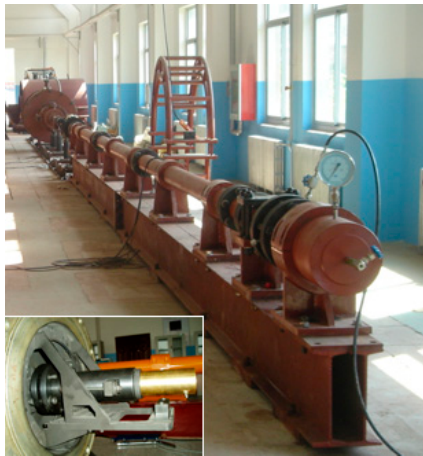
Figure 3. The two stage light-gas gun and magnetic velocimeter in Beijing Institute of Technology